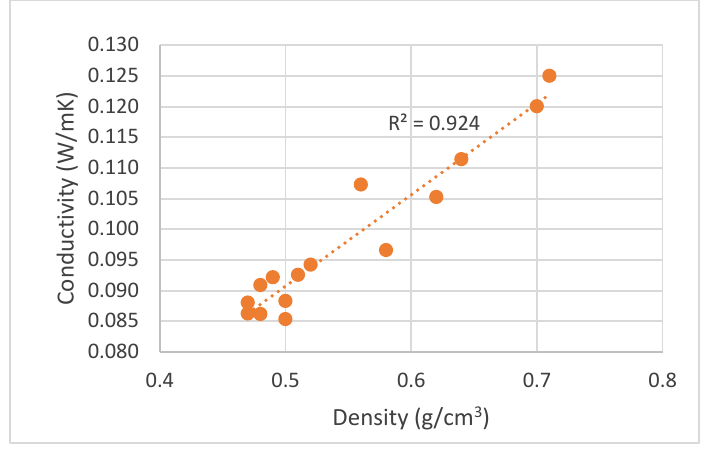
Figure 13. Correlation between conductivity variation and particleboard density.